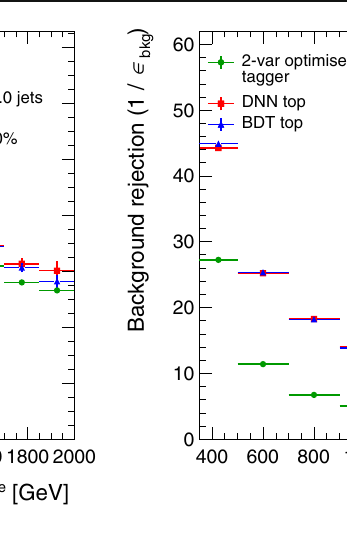
Fig. 5 The background rejection comparison of W -boson taggers at fixed 50% signal efficiency working point ( a ) and top-quark taggers at fixed 80% signal efficiency working point ( b ) for the multivariate jet-shape-based taggers as well as the two-variable optimised taggers, which are composed of a selection on m comb and D 2 in the case of